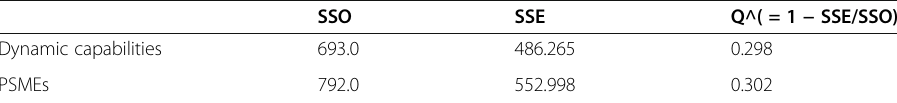
Table 6 Construct cross-validated